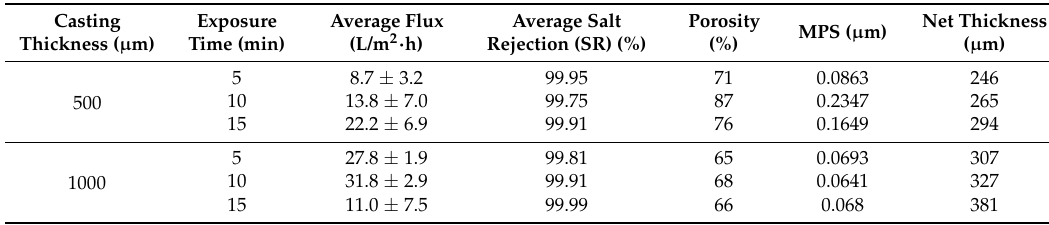
Table 5. Summary of direct-contact membrane distillation (DCMD) performance using membrane samples fabricated at 80% RH and 12% w / w PVDF casting solution.